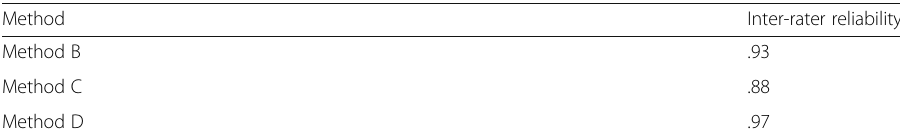
Table 3 Results of inter-rater